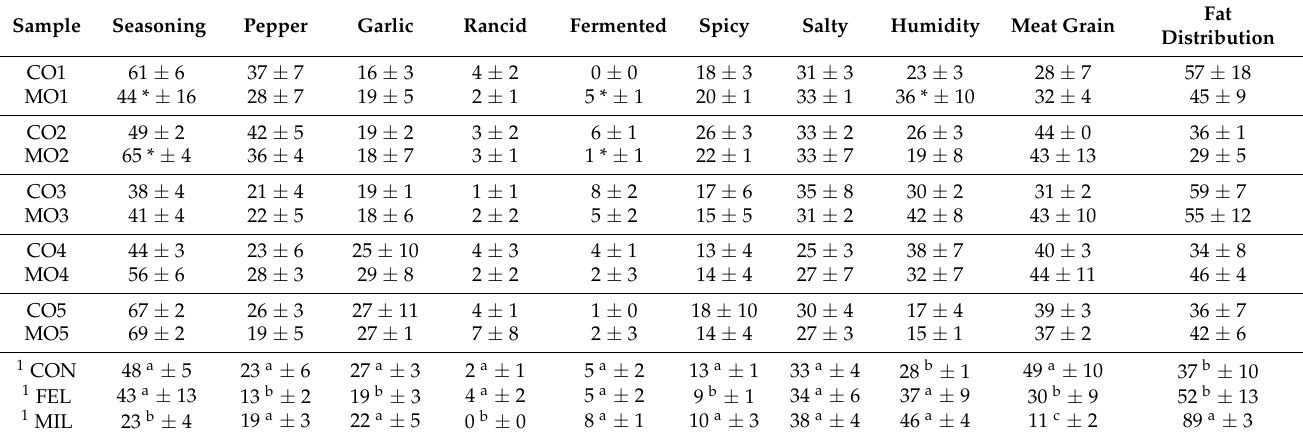
Table 3. Sensory results for salami samples. Mean values ± standard deviations of sensory